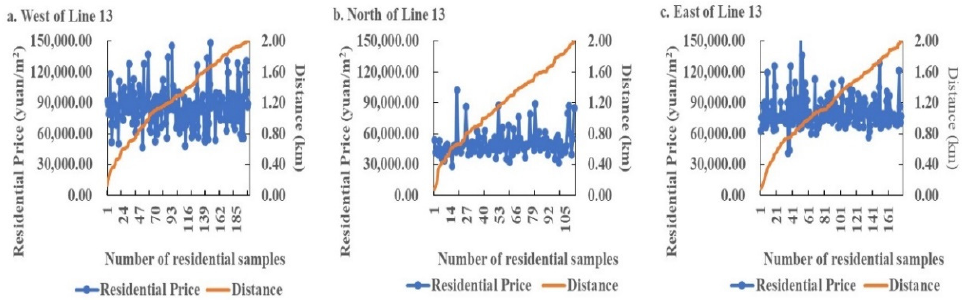
Figure 3. Relationship between residential price and the distance to the nearest subway station in each area along Metro Line 13.